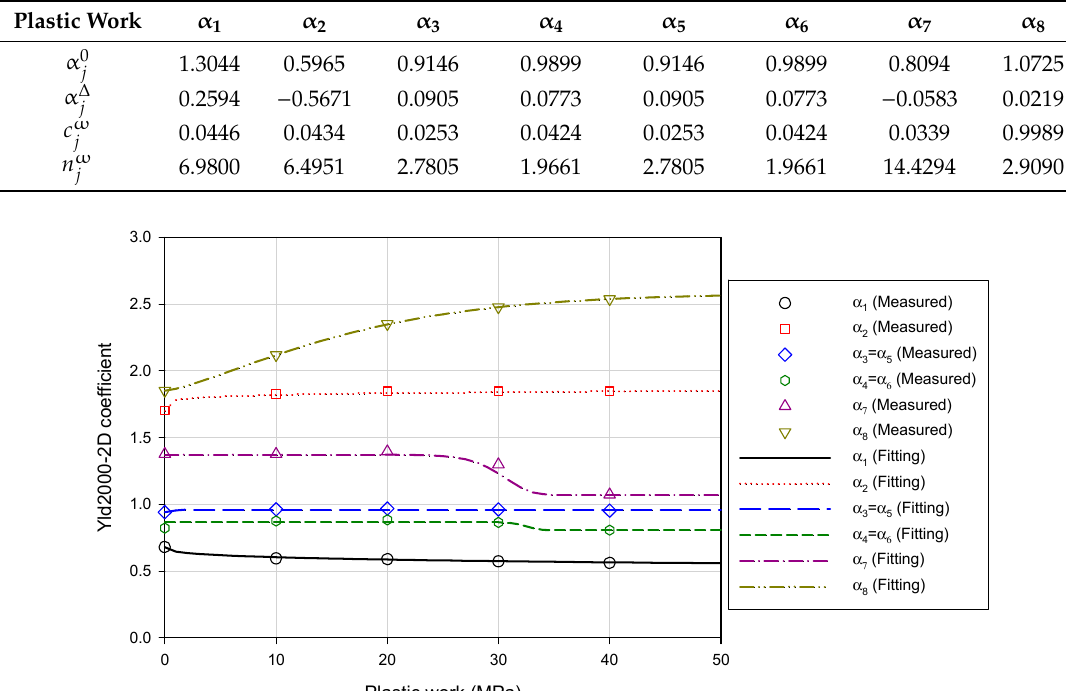
Figure 9. Evolutions of the parameters of the plastic potential function (Yld2000-2d function) for the niobium sheet with respect to the plastic